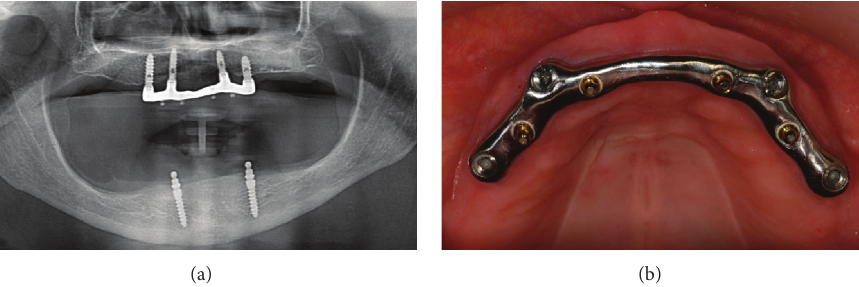
Figure 5: The maxillary overdenture (OD) at the 3-year follow-up: panoramic control radiograph (a); clinical view of the bar (b).